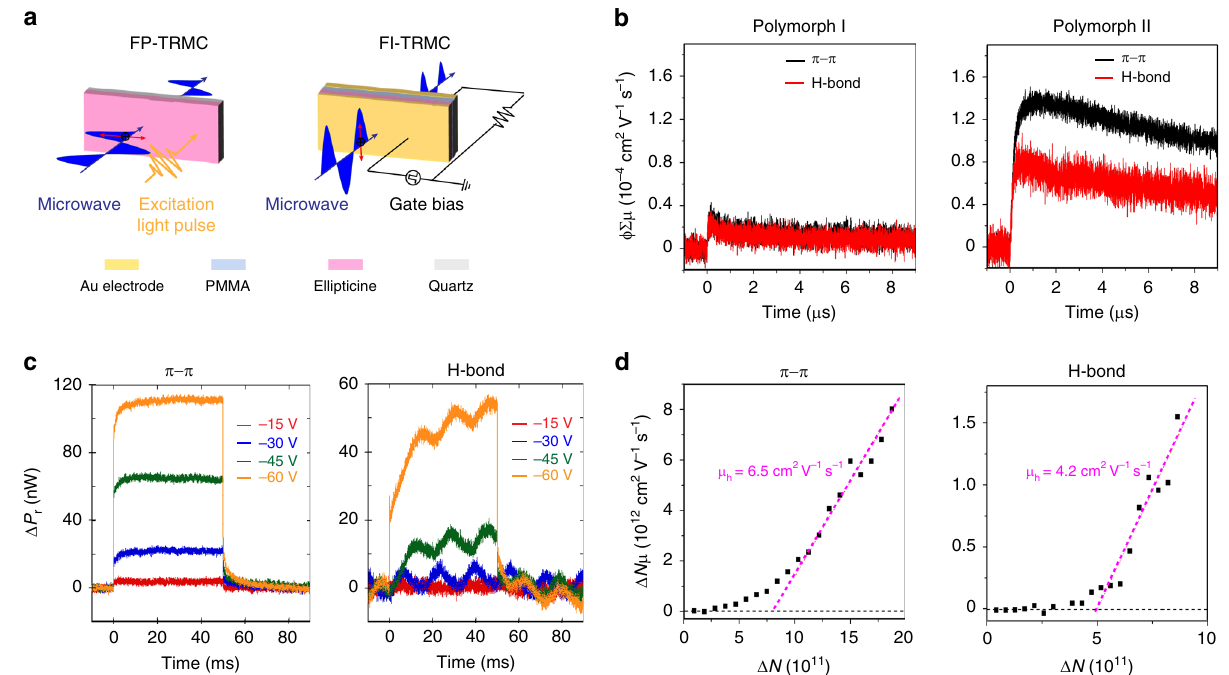
Fig. 5 Intrinsic carrier transport properties via microwave conductivity. a Schematic of fl ash-photolysis and fi eld-induced time-resolved microwave conductivity (FP- and FI-TRMC) techniques. b FP-TRMC response of ellipticine samples of polymorph I and II. ϕ ∑ μ denotes the product of charge separation quantum yield ( ϕ ) and the sum of photo-generated hole and electron mobilities ( ∑ μ ); ϕ ∑ μ is proportional to photoinduced conductivity change. c Gate bias effect on FI-TRMC signals for hole transport along the π − π stacking and the H-bonding directions. Δ P r denotes the change in the power of re fl ected microwave during gate bias pulsing; Δ P r is proportional to fi eld-induced conductivity change. d Correlation between holes number Δ N and pseudo electrical conductivity Δ N μ along the π − π stacking and H-bonding